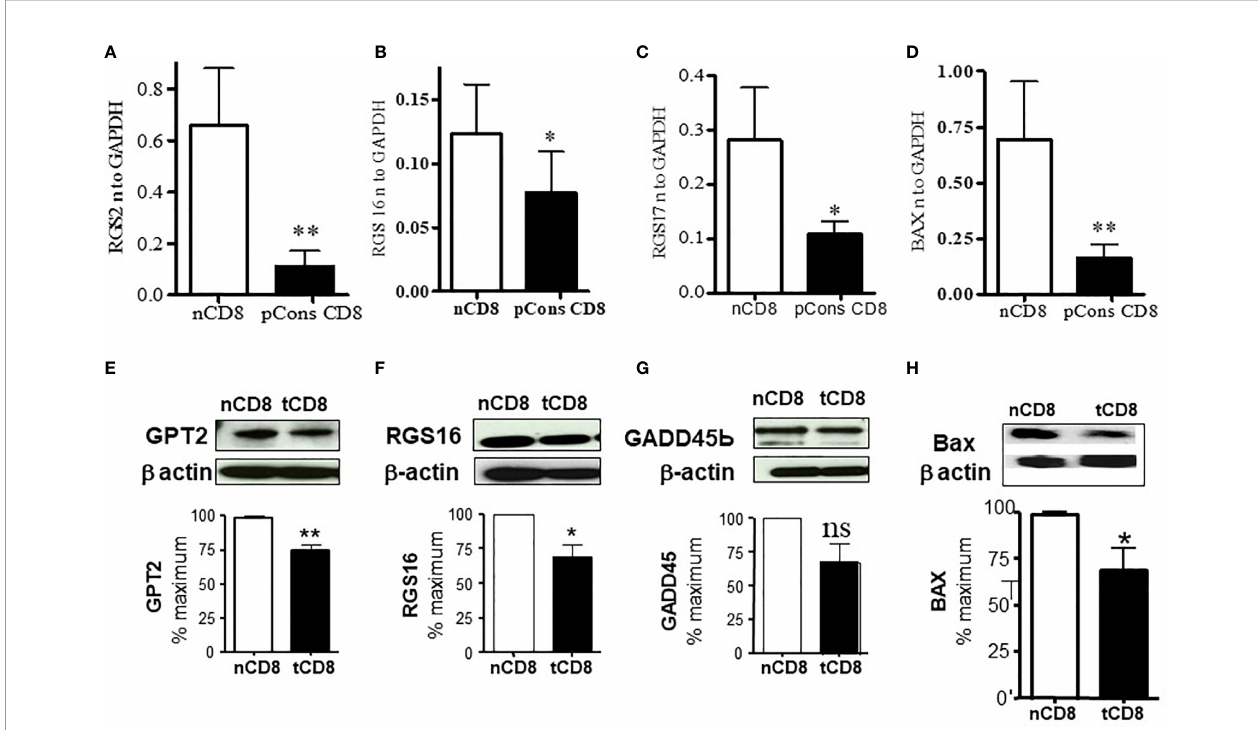
FIGURE 3 | pCons treatment downregulated the expression of Regulator of G protein signaling (RGS2, RGS16, and RGS17) and Bax (Bcl2-associated X protein) in pCons-induced CD8 + T cells. Female 10-12-wk old BWF1 mice (n=3-5 mice) were treated with pCons (1 mg i.v. ). After one-two week, splenocytes were obtained both from naïve and pCons-treated BWF1 mice. Naïve CD8 + T cells and pCons-treated CD8 + T cells were isolated from BWF1 mice spleen cells using microbeads from (Miltenyi Biotech (Auburn, CA, USA). Splenocytes were labelled with CD8-speci fi c antibody, and naïve and pCons-treated CD8 + T cells sorted by FACS. Cells were lysed with RNA lysis solution (Trizol) and total cellular RNA obtained. Murine primers and probes (RGS2, RGS16, RGS17, BAX, and GAPDH) were obtained from Applied Biosystems (Foster City CA, USA). Real time PCR was performed with 100 ng of RNA with gene speci fi c primers and probes comparing naïve and pCons-treated CD8 + T cells for each protein. (A) RGS2 normalized to GAPDH in naïve CD8 + T cells vs pCons-treated CD8 + T cells. (B) RGS16. (C) RGS17. (D) BAX. Data was normalized with GAPDH mRNA levels. (E – H) . Western blot analyses. (E) GPT2 protein level normalized to b -actin in naïve CD8 + T cells vs pCons-treated CD8 + T cells. (F) RGS16. (G) GADD45 b . (H) BAX. Data was normalized to b actin protein levels. *p < 0.05, **p < 0.001. ns, not signi fi